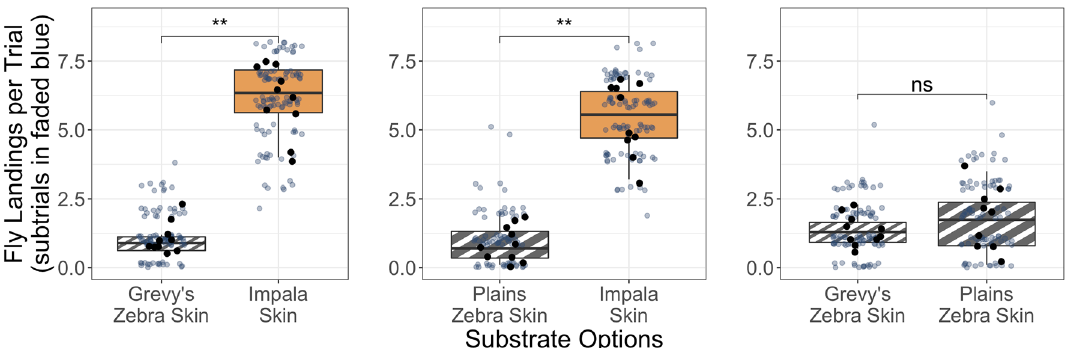
Figure 1. Number of fly landings per trial on zebra and impala skins for each paired-choice treatment (statistics run on mean landings per trial, shown by large black points, which were mean counts across subtrials within a trial session, shown in faded navy points). ns no significant difference, ** p <